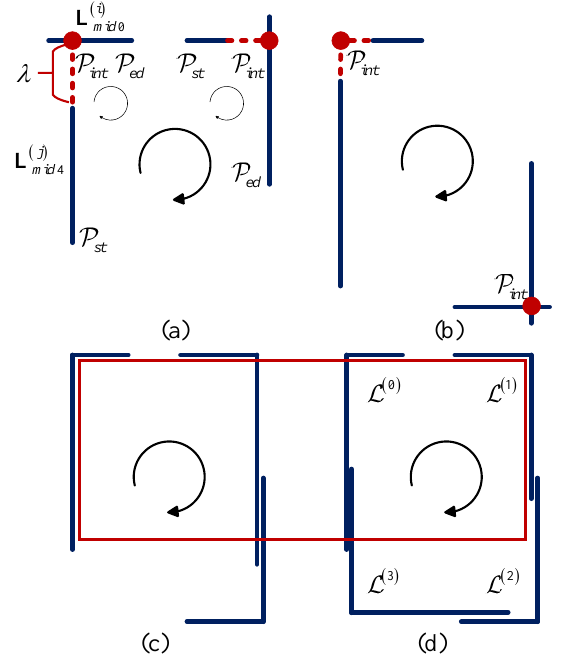
Figure 8. Four situations that can form an L-shaped structure are demonstrated in ( a , b ). The red dots represent the virtual or actual intersections of two lines with distance tolerance value λ . The attribution P st , P P L ( i ) are always clockwise. Four situations of L-shaped structure to form temp parking int , ed of spaces are demonstrated in sub-figures ( a – d ). In sub-figure ( d ), L-shaped structures in each temp parking space are also clockwise. The red rectangle in ( c , d ) is the situation that an error detection occurred without removing an L-shaped structure between